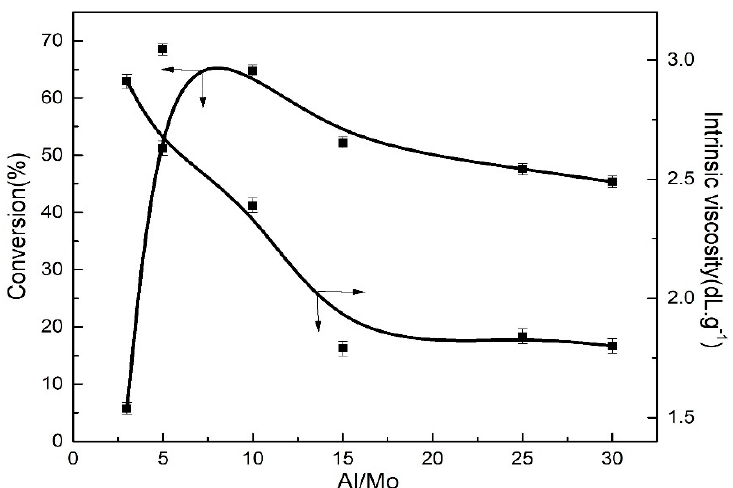
Figure 4. Effect of Al:Mo mole ratio from 3 to 30 on the polymerization conversion and intrinsic viscosity at a Bd:Ip mole ratio of 9:1. Polymerization conditions: [M] = 0.18 g · mL − 1 , Mo:[M] = 4 × 10 − 4 , TNPP:Mo = 6, T = 60 °C, nBd:nIp = 9/1, t = 7 h.